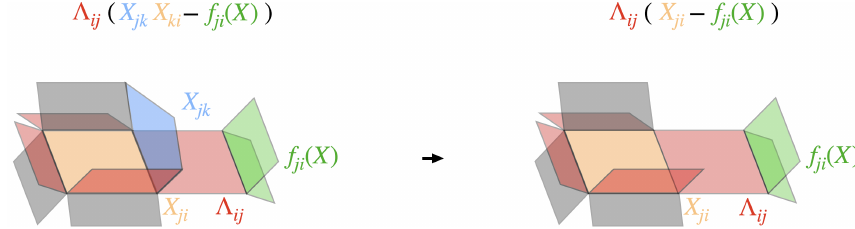
Figure 12 . Generating a massive chiral-Fermi pair by